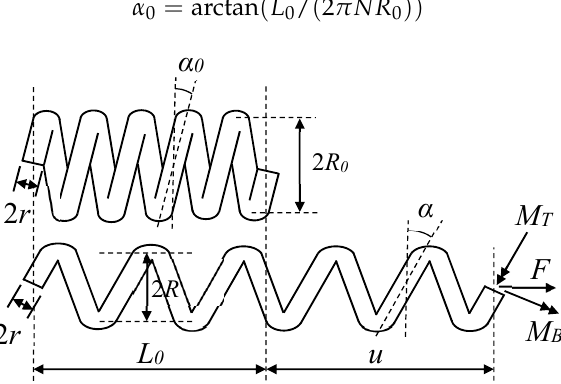
7 of 23 Table 1. The formulas for the material parameters in the shear stress-strain model. Calculation formula Parameter G A = E A /2(1+ ν ) Shear modulus of austenite G M = E M /2(1+ ν ) Shear modulus of martensite τ Ms = σ Ms / 3 Starting shear stress of the martensitic transformation τ Mf = σ Mf / 3 Final shear stress of the martensitic transformation τ As = σ As / 3 Starting shear stress of the austenitic transformation τ Af = σ Af / 3 Final shear stress of the austenitic transformation γ L = ε L Maximum residual shear strain 2.2. Constitutive Model of an SMA Helical Spring When an SMA helical spring undergoes a large axial deformation, the cross section of the spring wire has to resist a large bending moment in addition to the torque. To consider the influence of the